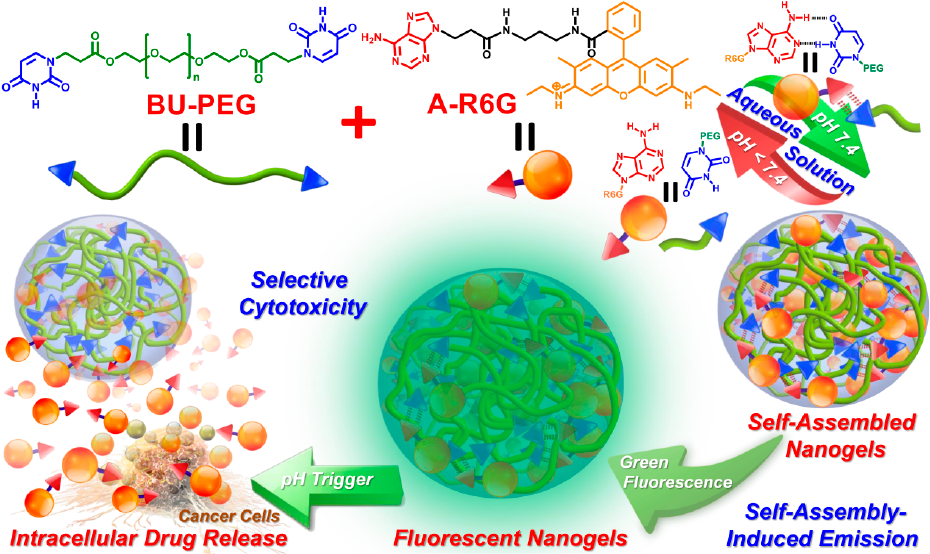
Scheme 1. Schematic illustration of the co-assembly process, fluorescent properties, and cancer cell-selective cytotoxic behavior of hydrogen-bonded A-R6G/BU-PEG complexes. The upper-right green and red arrows represent the association and dissociation of the complementary A–U base pairs under various pH conditions.